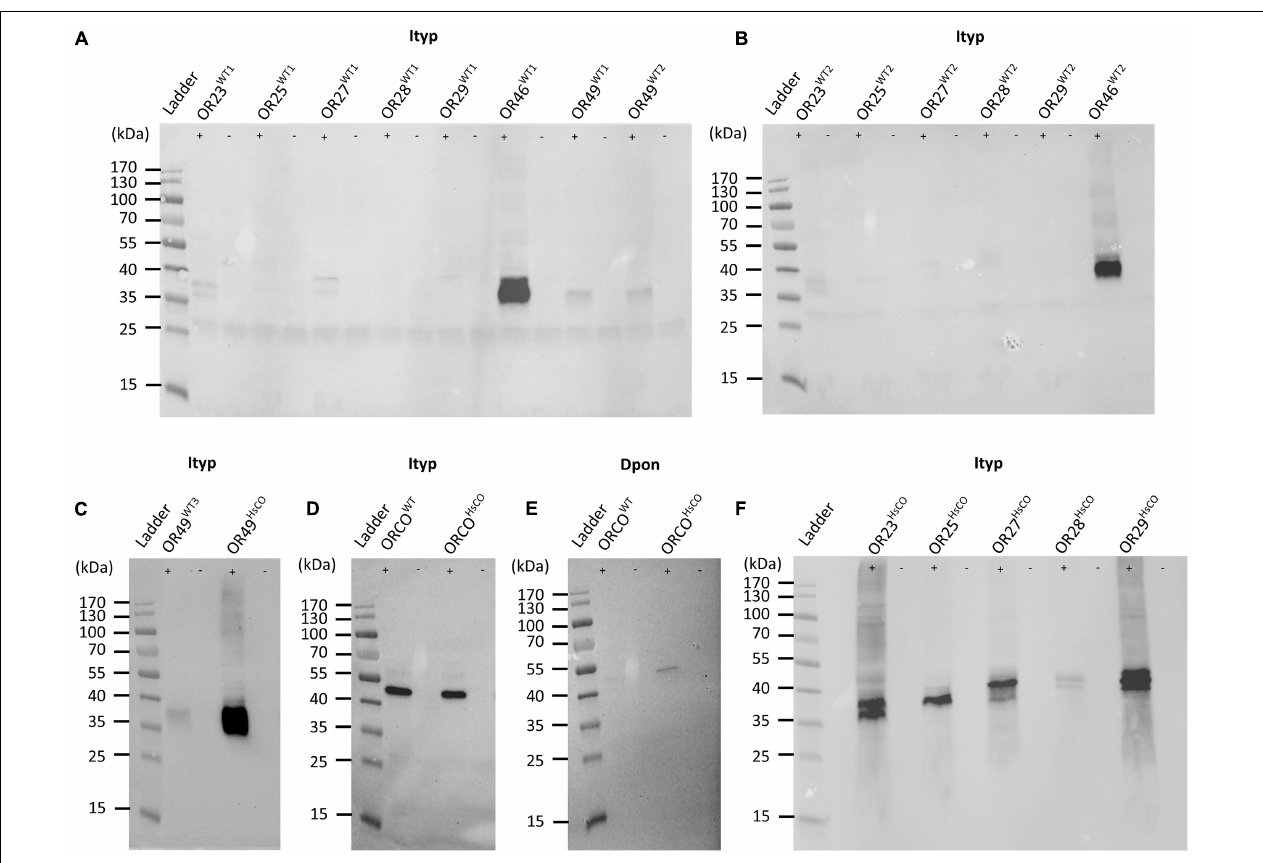
FIGURE 1 | Western blots of HEK293 cells transfected with bark beetle Myc-tagged Orco genes and V5-tagged odorant receptor (OR) genes. (A) Detection of Ips typographus (Ityp) OR proteins from the first set of cell lines co-transfected with the wildtype (WT) ItypOrco gene and wildtype genes for ItypOR23, ItypOR25, ItypOR27, ItypOR28, ItypOR29, ItypOR46, and ItypOR49 (two cell lines for this gene: WT1 and WT2). Data for ItypOR46 and ItypOR49 from Yuvaraj et al. (2021) (modified image under CC BY 4.0 license; https://creativecommons.org/licenses/by/4.0/). (B) Detection of ItypORs from the second set of cell lines co-transfected with the wildtype ItypOrco gene and wildtype genes for ItypOR23, ItypOR25, ItypOR27, ItypOR28, ItypOR29, and ItypOR46. (C) Detection of ItypOR49 from cells co-transfected with the wildtype ItypOrco gene and the wildtype (third cell line: WT3) or codon optimized (HsCO) gene for ItypOR49. (D) Detection of Orco proteins from cells expressing the wildtype ItypOrco gene or the codon optimized ItypOrco gene, and (E) the wildtype Dendroctonus ponderosae (Dpon) Orco gene or the codon optimized DponOrco gene. (F) Detection of ItypORs from cells co-transfected with the wildtype ItypOrco gene and codon optimized genes for ItypOR23, ItypOR25, ItypOR27, ItypOR28, and ItypOR29. OR and Orco proteins were only detected from cells induced (+) to express the exogenous genes, and not from non-induced ( − ) cells, indicating proper regulation by the repressor system (A–F) . Note, the detection of some receptors as “double-bands” is likely due to different protein confirmations in the